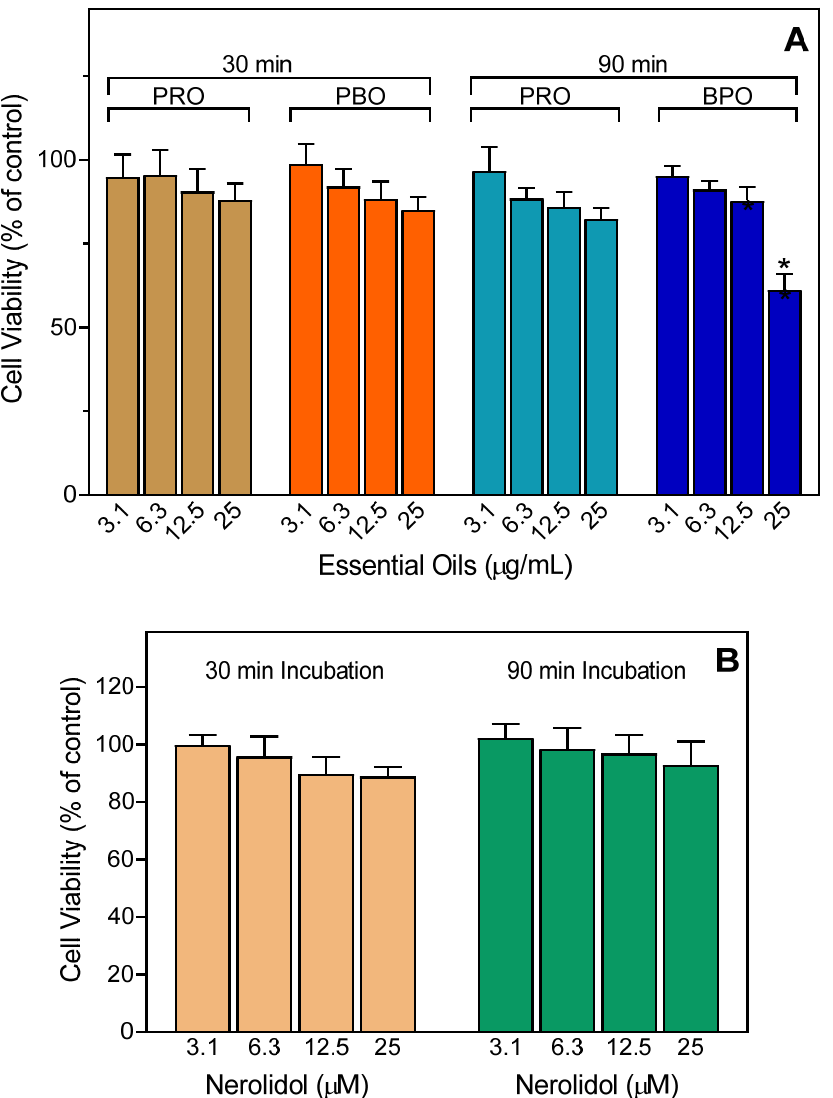
Figure 4. Evaluation of the cytotoxicity of PRO, PBO, and nerolidol. Human neutrophils were preincubated with the indicated concentrations of essential oil ( A ) or pure nerolidol ( B ) for 30 min or 90 min, and cell viability was analyzed, as described. Values are the mean ± SD of triplicate samples from one experiment that is representative of three independent experiments with similar